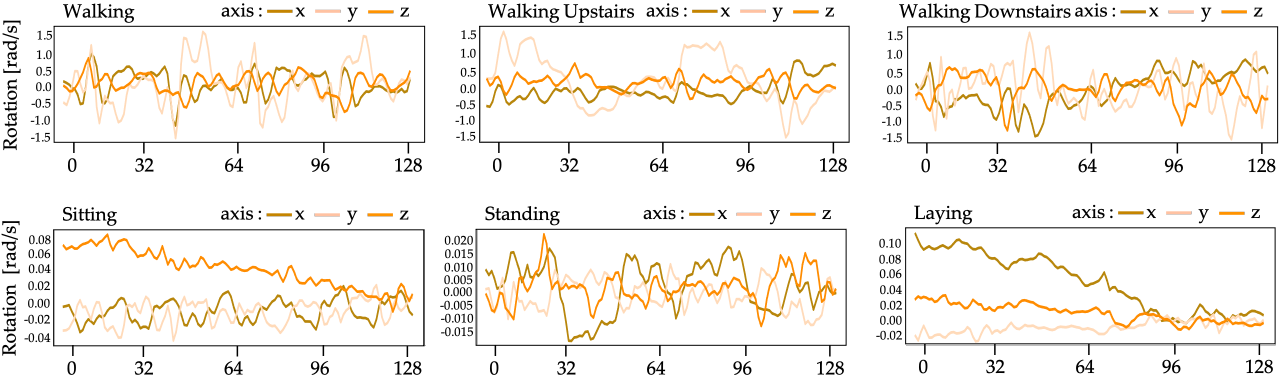
Figure 6. Gyroscope data from UCI-HAR